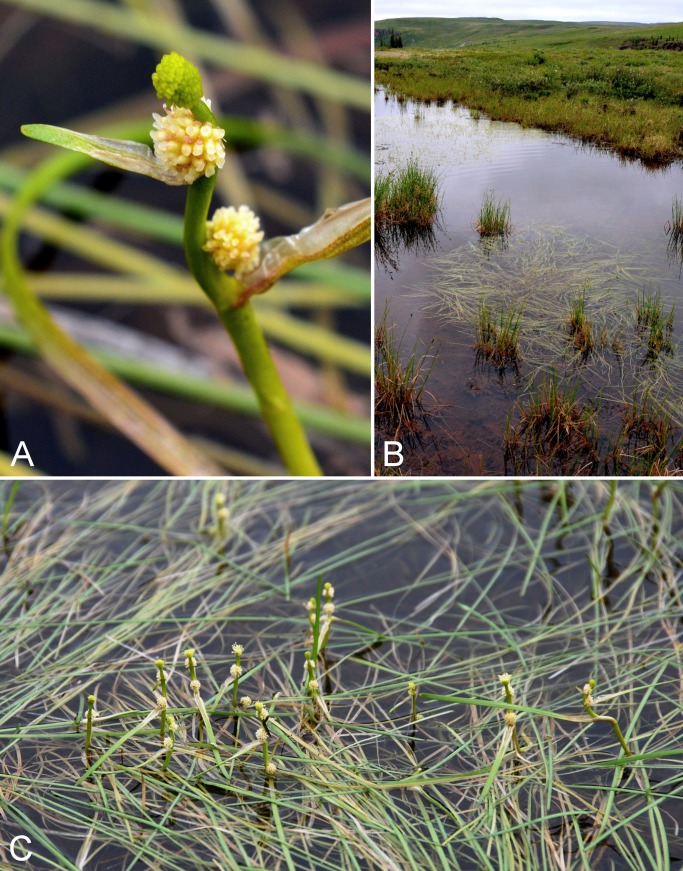
Sparganium hyperboreum.(A) Inflorescence, Saarela et al. 3617. (B) Habitat, Saarela et al. 3617. (C) Habit, Saarela et al. 3617. Photographs by P. C. Sokoloff (A, B) and J. M. Saarela (C).